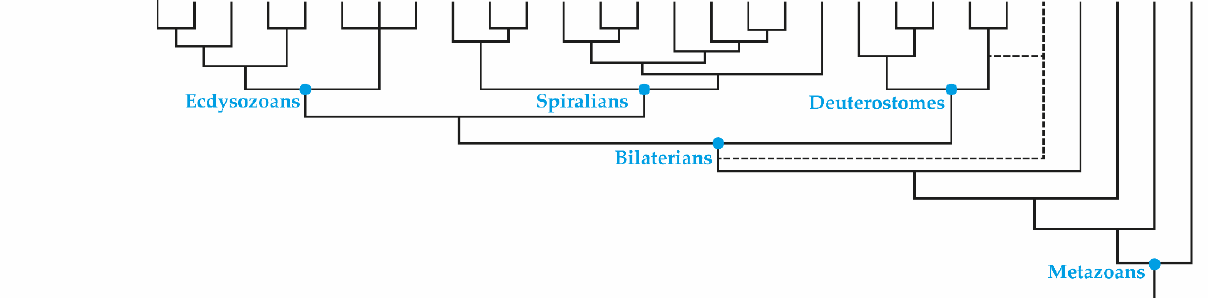
Figure 1. Glycinergic neurotransmission in metazoan animals. Consensus cladogram based on refs [38,39] showing evolutionary relationships of the main animal phyla. The dashed lines indicate that the position of the Xenacoelomorpha is still a matter of debate [40 – 42], which might potentially affect the monophyly of the deuterostomes [43]. The earliest branches of the tree are currently also unresolved, with different phylogenies placing either the Ctenophora or the Porifera as the sister group to all other animals [44 – 46], as indicated by the orange arrow and question mark. Asterisks mark animals without a nervous system. A. californica , Aplysia californica ; B. lanceolatum , Branchiostoma lanceolatum ; C. elegans , Caenorhabditis elegans ; C. intestinali s, Ciona intestinalis ; D. melanogaster , Drosophila melanogaster ; H. vulgaris , Hydra vulgaris . n.a.: data not available.